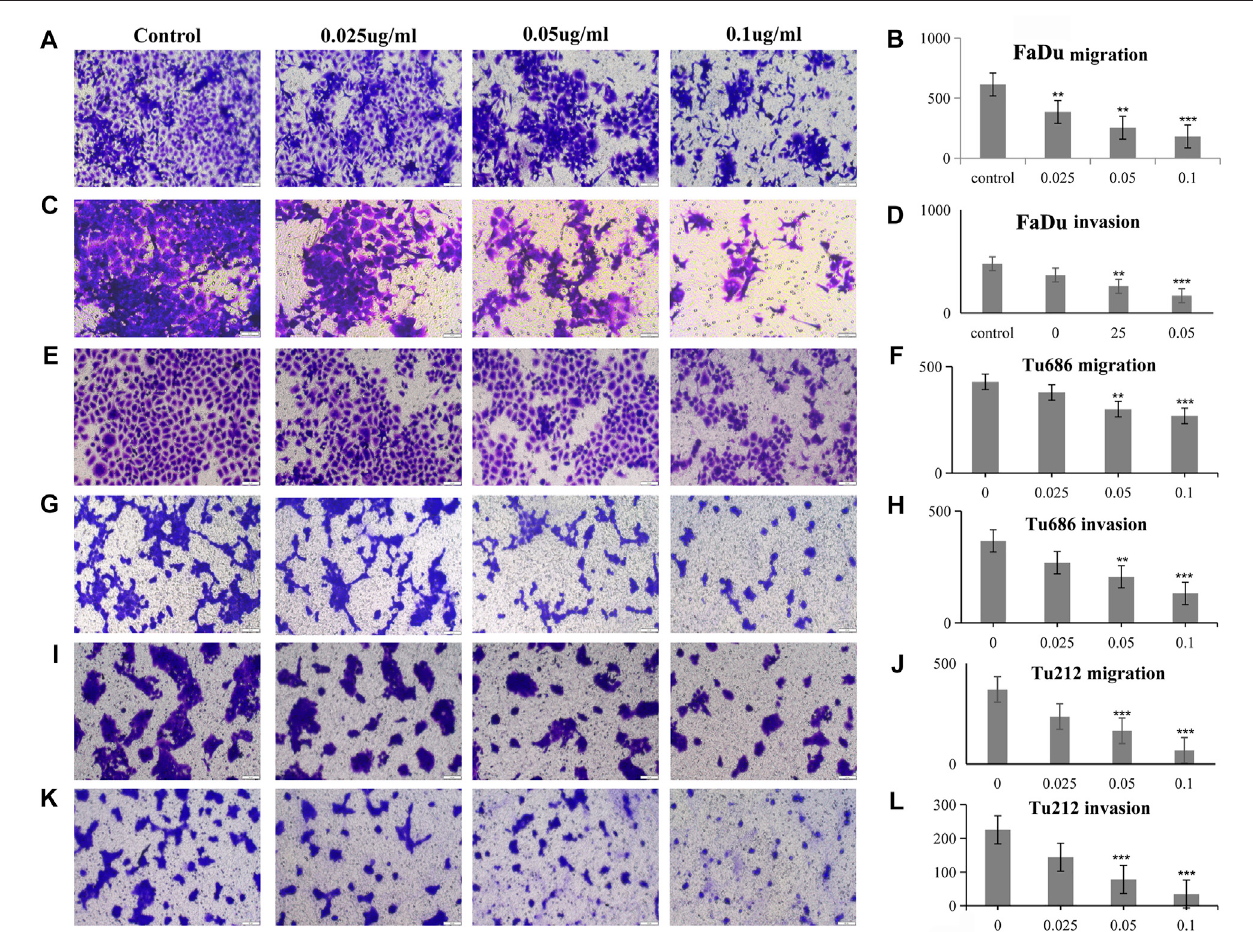
FIGURE 3 | PSII reduced the motility of human squamous cell carcinoma cell by transwell assay. (A) PSII inhibited FaDu cell mobility by migration. (B) The statistical fi gure of FaDu cell migration assay. (C) PSII inhibited FaDu cell mobility by invasion. (D) The statistical fi gure of FaDu cell invasion assay. (E) PSII inhibited Tu686 cell mobility by migration. (F) The statistical fi gure of Tu686 cell migration assay. (G) PSII inhibited Tu686 cell mobility by invasion. (H) The statistical fi gure of Tu686 cell invasion assay. (I) PSII inhibited Tu212 cell mobility by migration. (J) The statistical fi gure of Tu212 cell migration assay. (K) PSII inhibited Tu212 cell mobility by invasion. (L) The statistical fi gure of Tu212 cells invasion assay. Bars, 50 µm. All the experiments were carried out three times. The bar graphs and the table show quanti fi cation of the results, and each data represent the mean ± SD of three independent experiments (* p < 0.05; ** p < 0.01; *** p < 0.001 vs the control